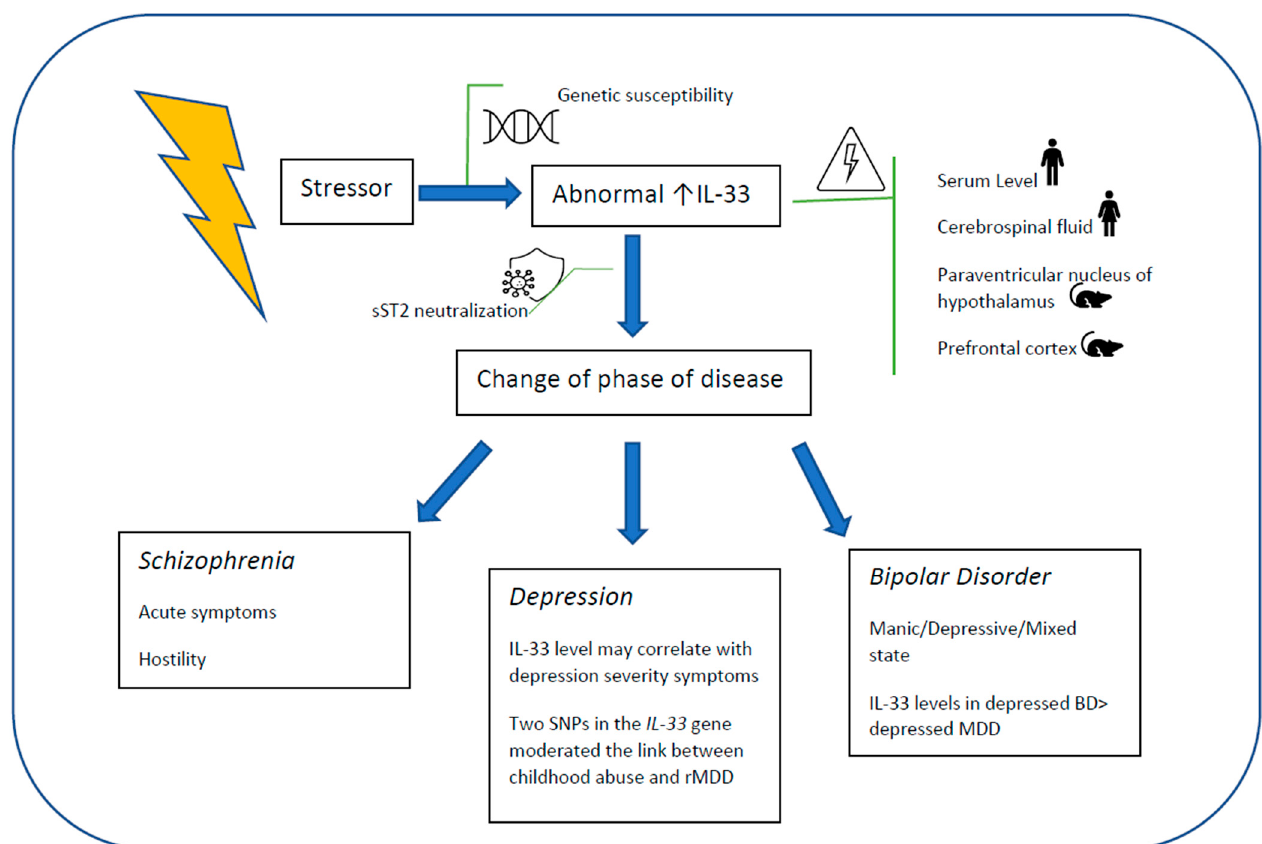
Figure 1. IL-33 levels correlated to disease phases after the intervention of a stressing agent.